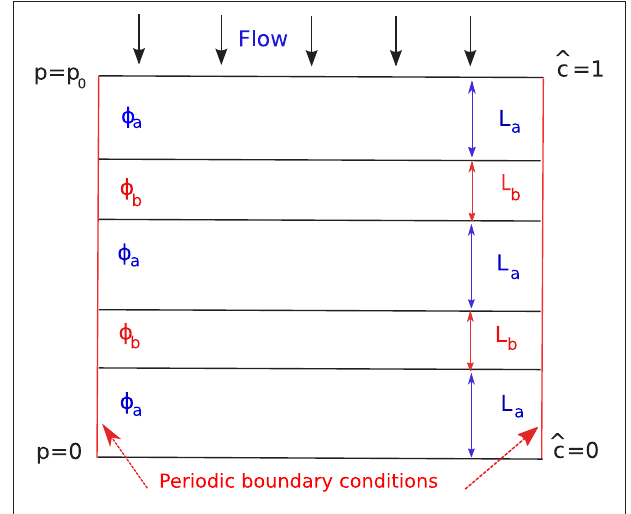
FIGURE 2 | Schematic of a model of stratified medium: alternating layers of porosities φ a and φ b